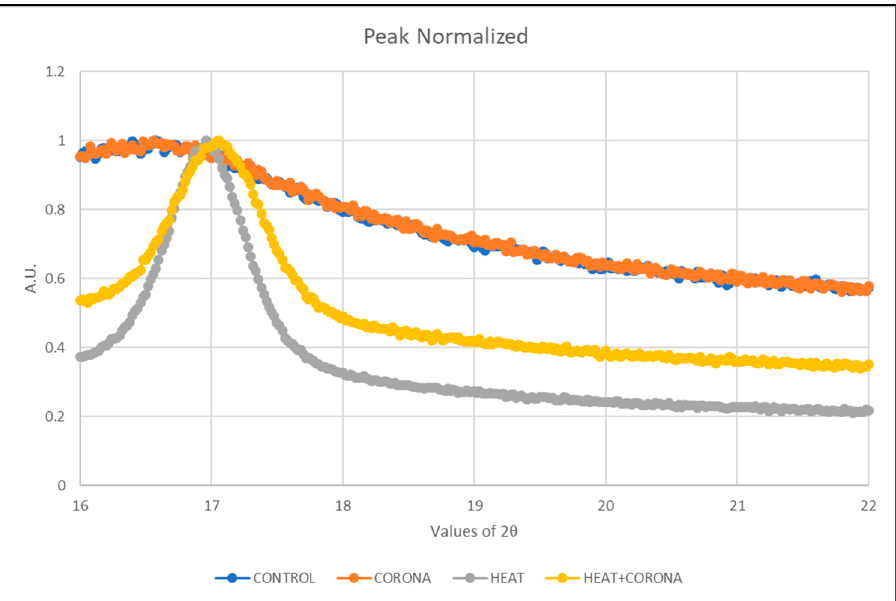
Figure 10. Normalized α -phase peak of PVDF nanofibers .